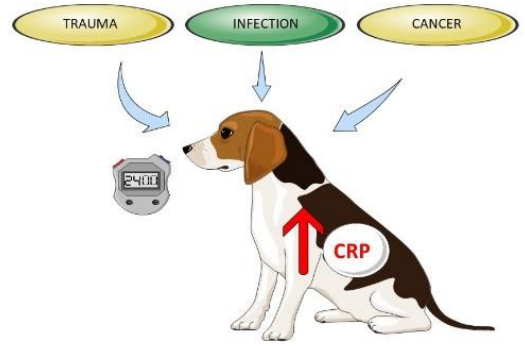
Figure 1. Factors inducing acute phase response, including CRP.